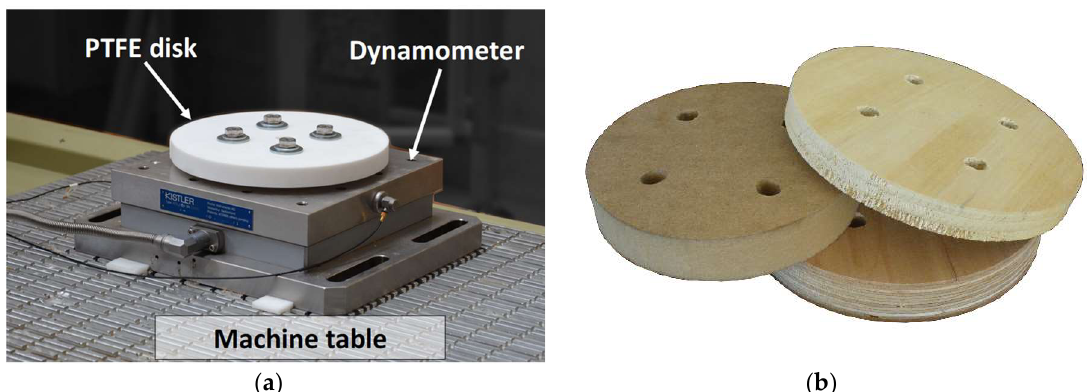
Figure 1. ( a ) Polytetrafluoroethylene (PTFE) disk after the preparation cuts installed on the dynamometer. The dynamometer is held on the machine table by a conventional vacuum suction system; ( b ) Medium Density Fiberboard (MDF), Beech LVL and Poplar Laminate Veneer Lumber (LVL) disks used in the tests.